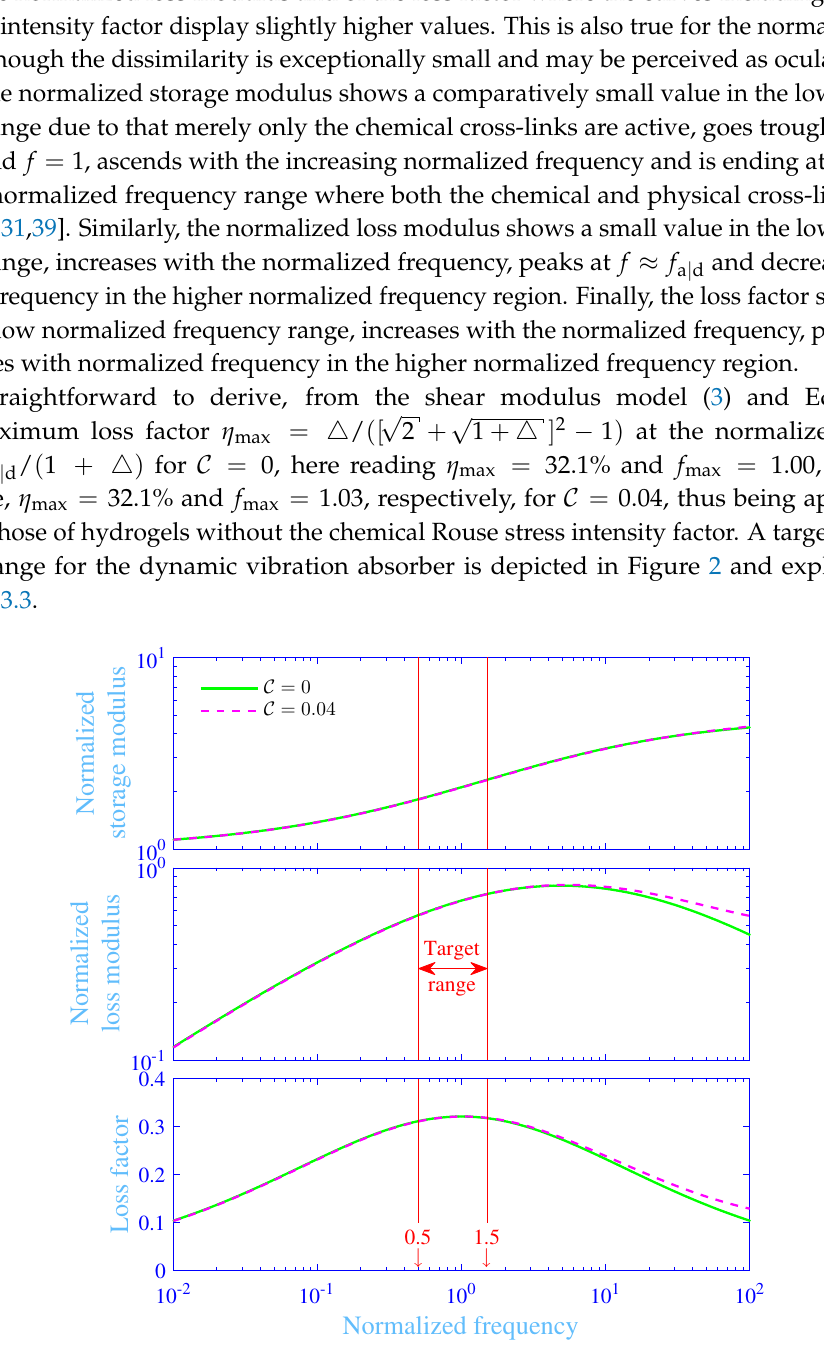
Figure 2. Normalized storage modulus, normalized loss modulus and loss factor versus the normalized frequency for the studied single network hydrogel at the chemical Rouse stress intensity factors C = 0 and 0.04, with (cid:52) = 3.9055 and f a | d =